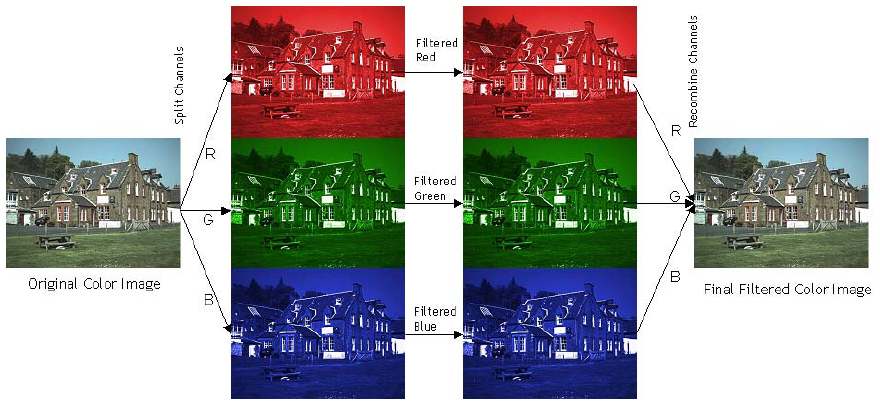
Figure 13. Overall scheme used to compare the Susan algorithm with the proposed method. The noisy color image is filtered by processing its color channels